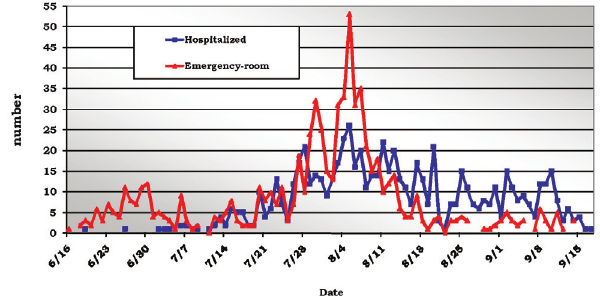
Figure 4 - Distribution of reportable cases in the HC-FMUSP according to the local of attending - June 16 to September